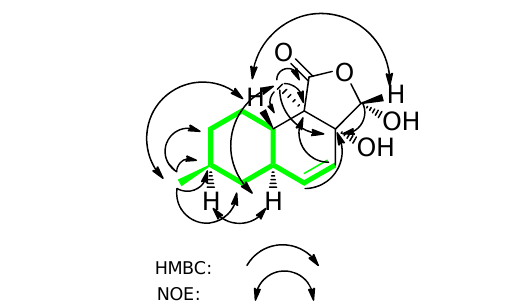
Figure 2. Key HMBC and NOE Correlations of compound 1 .